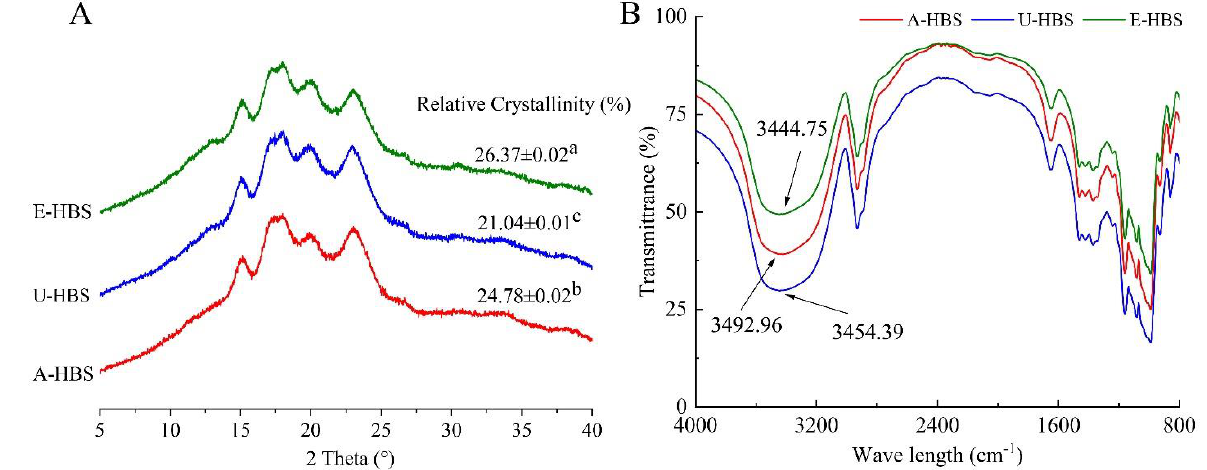
Figure 6. X-ray diffractograms ( A ), FTIR spectra ( B ) of highland barley starch samples. A-HBS: HBS extracted by alkali method; U-HBS: HBS extracted by ultrasonic method; E-HBS: HBS extracted by enzymatic method. Mean ± SD is calculated from triplicate measurements. Different lowercase letters represent significant difference ( p < 0.05).